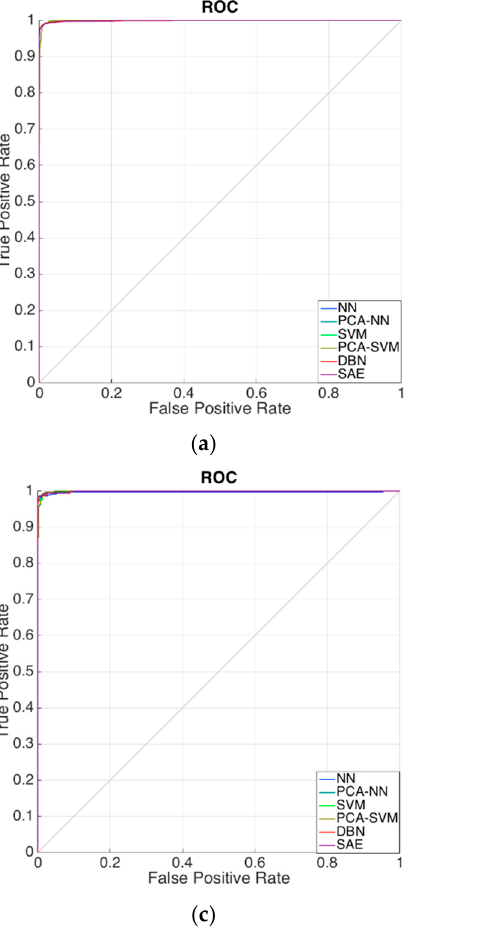
Figure 8. Receiver operating characteristics (ROC) curves of the classifiers. ( a ) ROC curve achieved based on 20,000 training, 4000 testing samples; ( b ) Zoomed in map of ( a ); ( c ) ROC curve achieved based on 4,000 training, 800 testing samples; ( d ) Zoomed in map of ( c ).